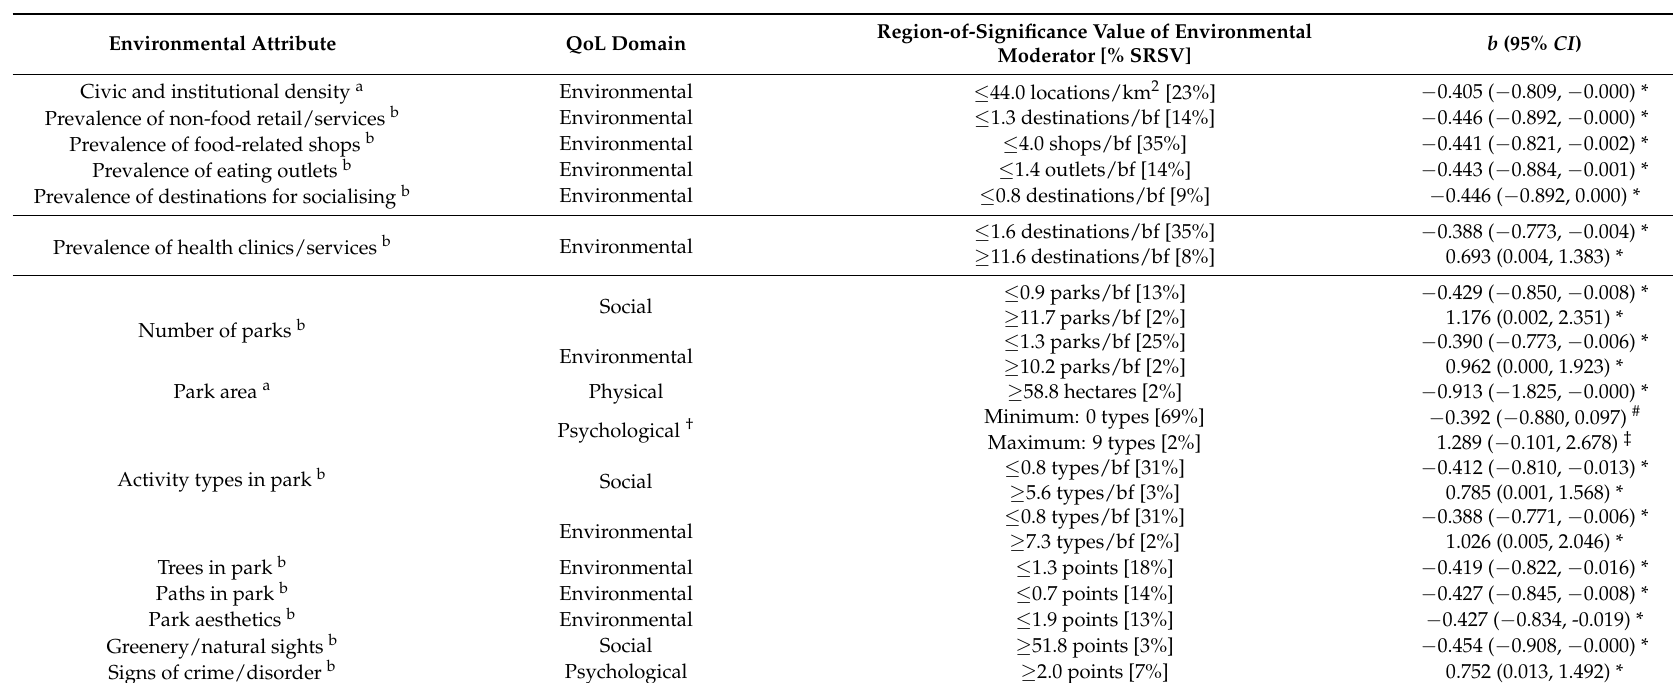
Table 3. Associations between living arrangements (reference group: living with others) and quality of life (QoL) domains at region-of-significance threshold values of neighbourhood physical environmental attributes